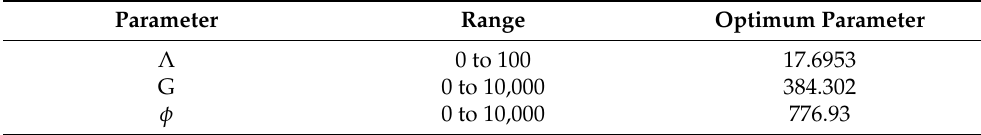
Table 5. Range of optimal controller parameters and outcomes.